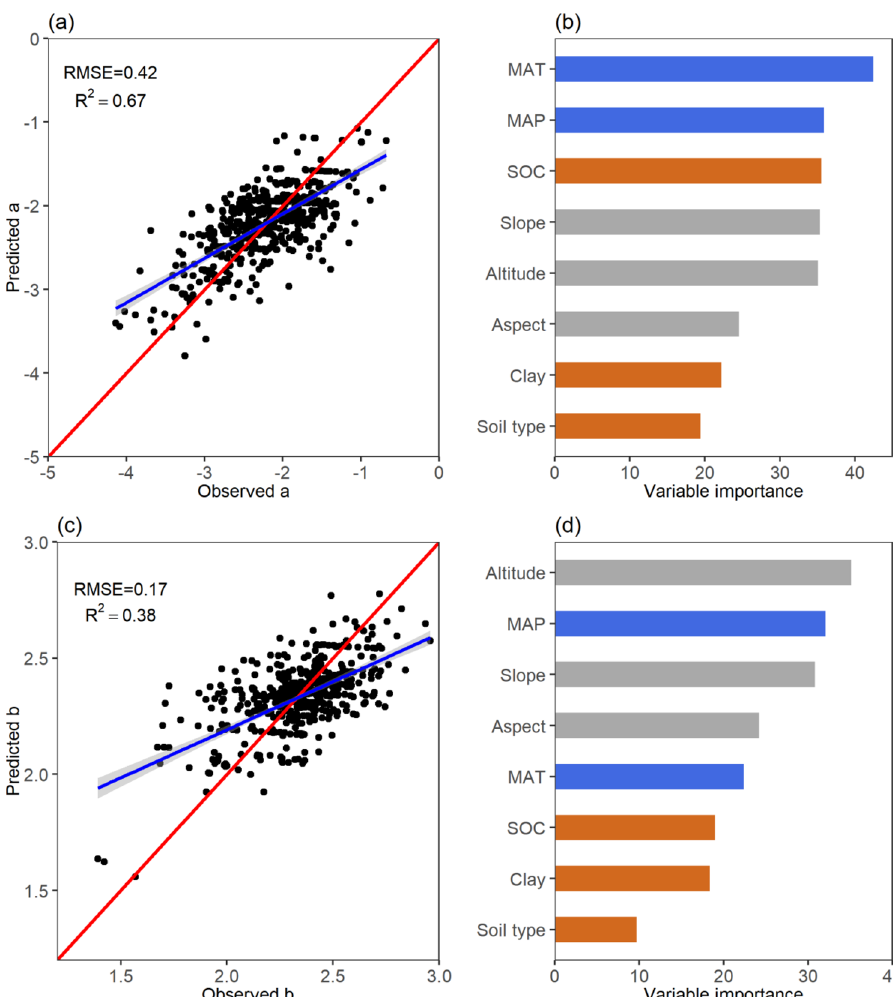
Figure 2. Model performance and variable importance of allometric model (LnW = a + b*Ln(D)) parameters predictions. ( a ) Model performance for parameter a ; ( c ) Model performance for parameter b . RMSE indicates root mean square error; R 2 indicates R squared. ( b ) Variable importance in predicting parameter a ; ( d ) Variable importance in predicting parameter b . Blue bars represent climatic factors; gray bars represent terrain factors; brown bars represent edaphic